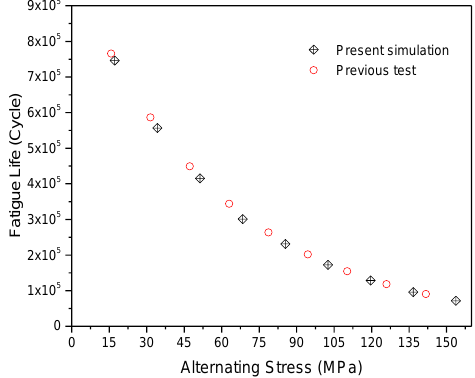
Figure 9. Validation Results: Benchmarking with Previous Test [34] Figure 9: Validation results: benchmarking with previous test